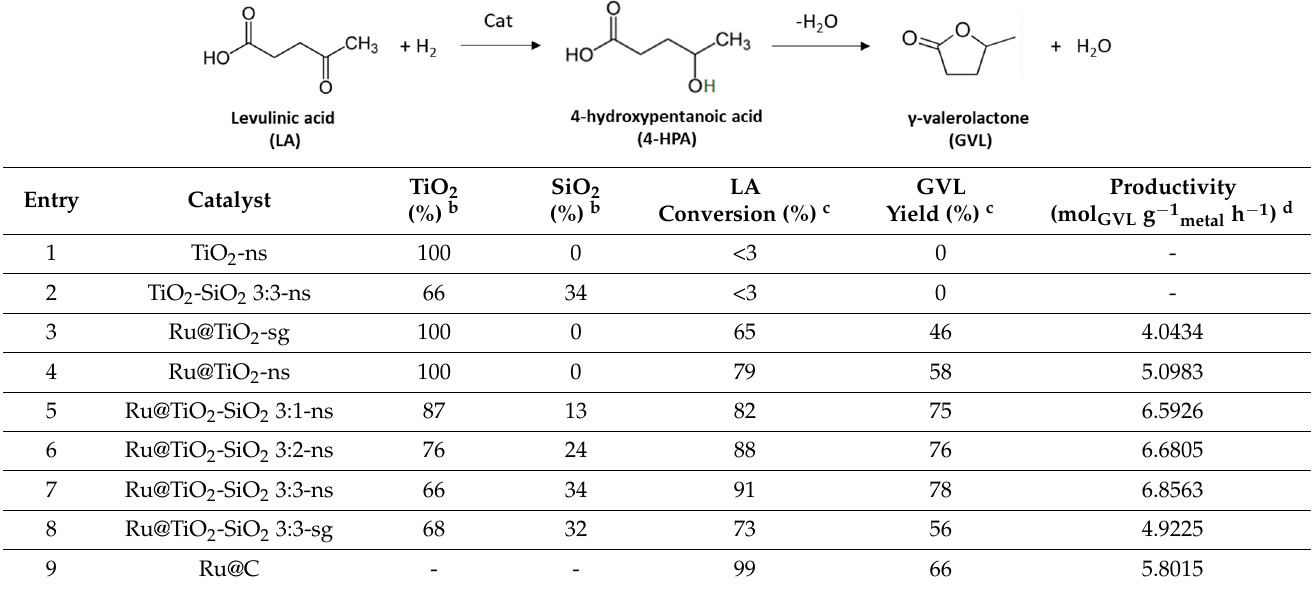
Table 3. Catalytic hydrogenation of LA to GVL with the different Ru-based catalysts a